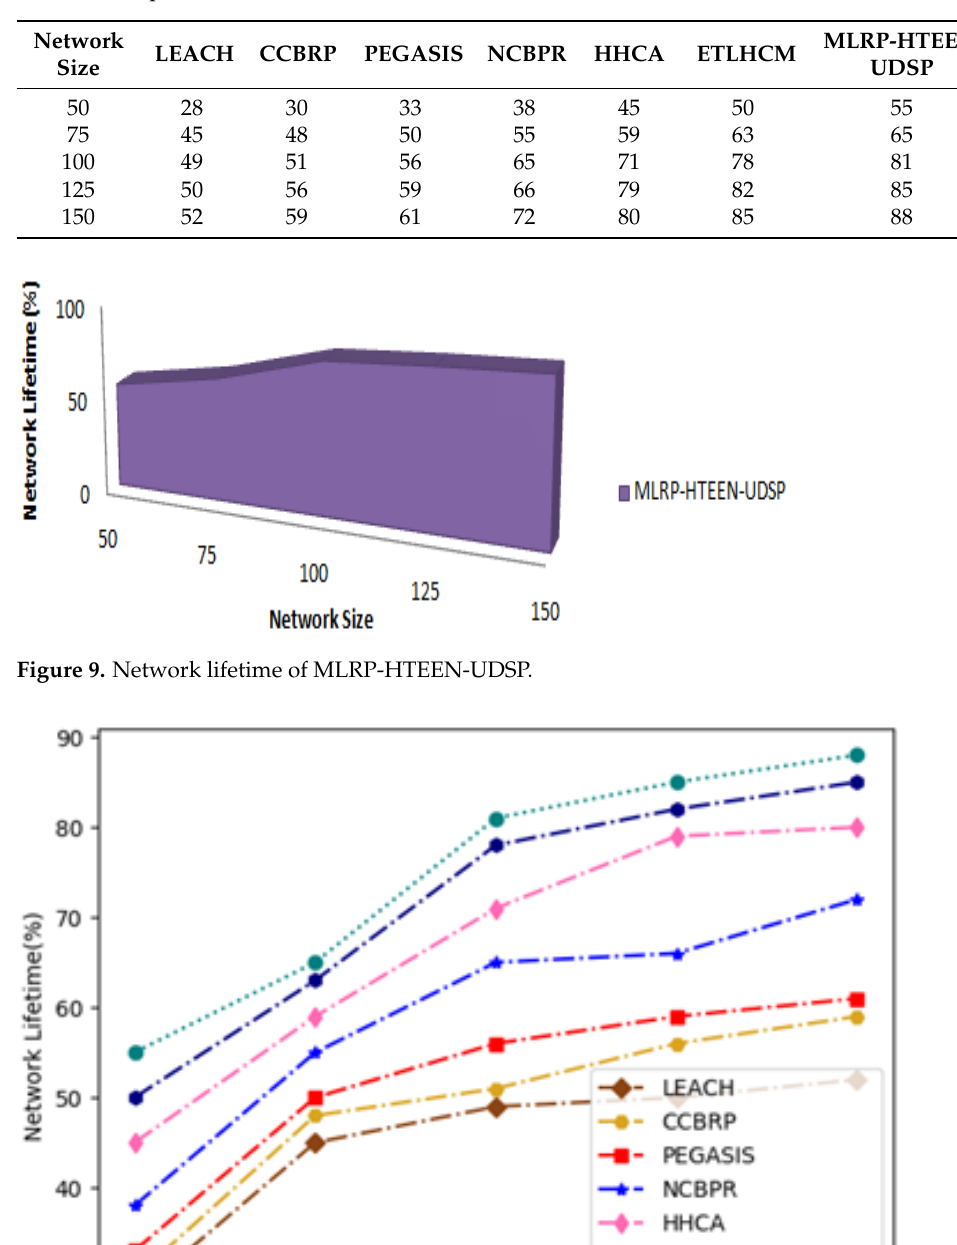
Table 5. Comparison of network Lifetime.